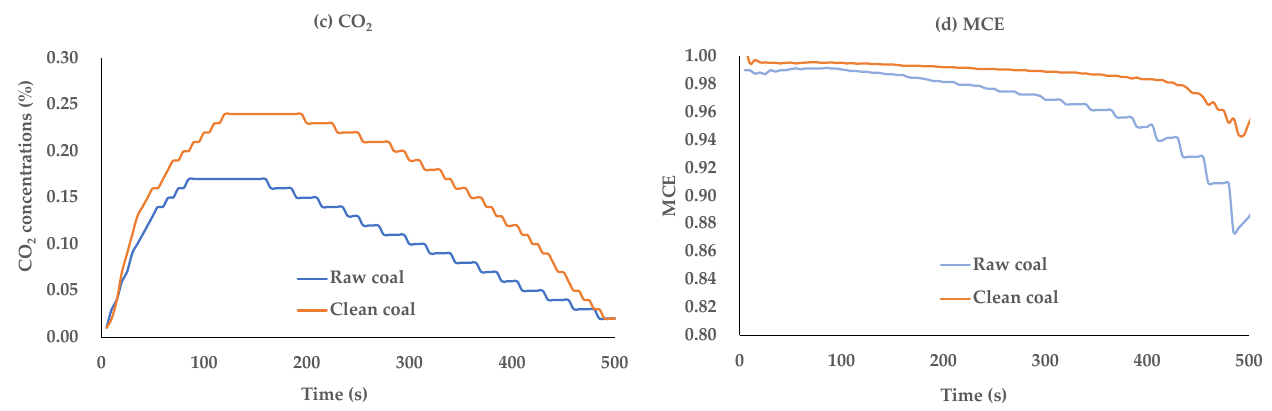
Figure 12. Air pollutant emissions of ( a ) the concentration of SO 2 ; ( b ) the concentration of CO; ( c ) the concentration of CO 2 ; ( d ) the modified combustion efficiency from the combustion of the raw coal and its clean coal using a dry coal cleaning system with two-stage corona electrostatic processes.